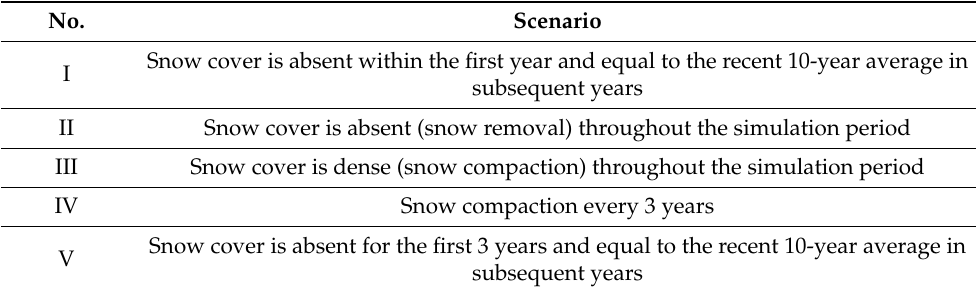
Table 7. Snow removal/compaction scenarios in the